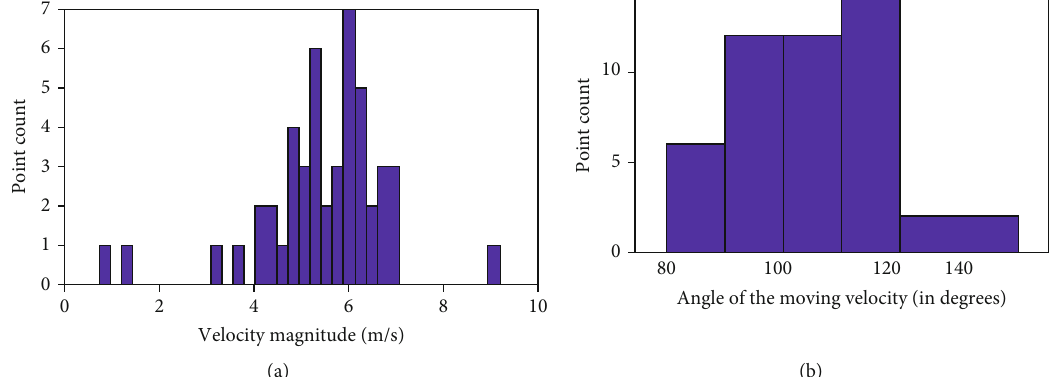
Figure 13: (a) Velocity magnitude histogram and (b) velocity angle